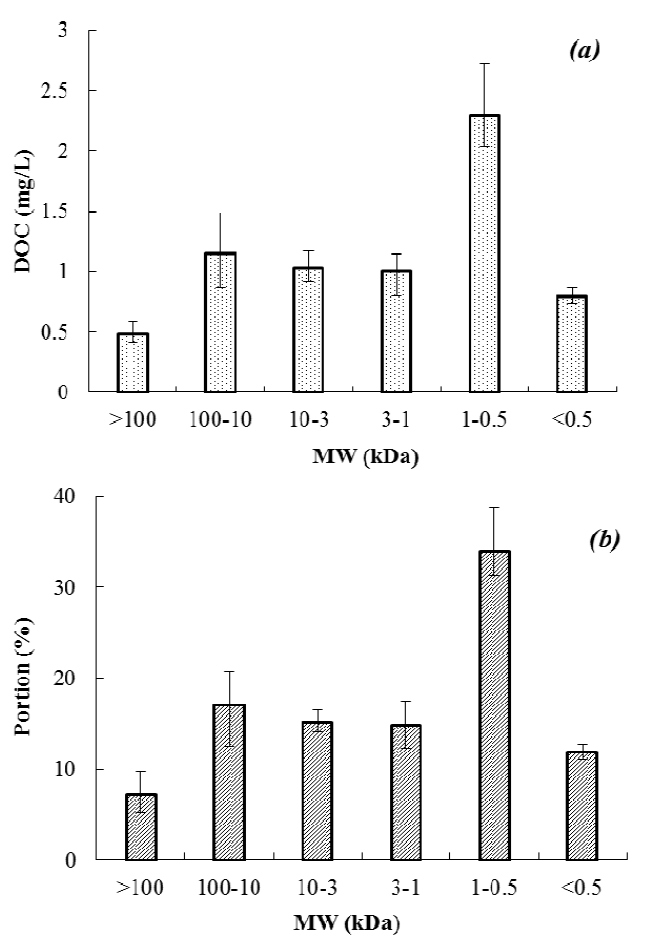
vicinity [21,24], and accounted for 56% of the total DOC. The low MW fractions were also considered the dominant factor in the formation of regulated DBPs during exposure to chlorination. Figure 2. The DOC concentration ( a ) at each molecular weight (MW) fraction group and their portion ( b ) in total DOC of the raw water (the presented data in the figure are the average of the observations for raw water in